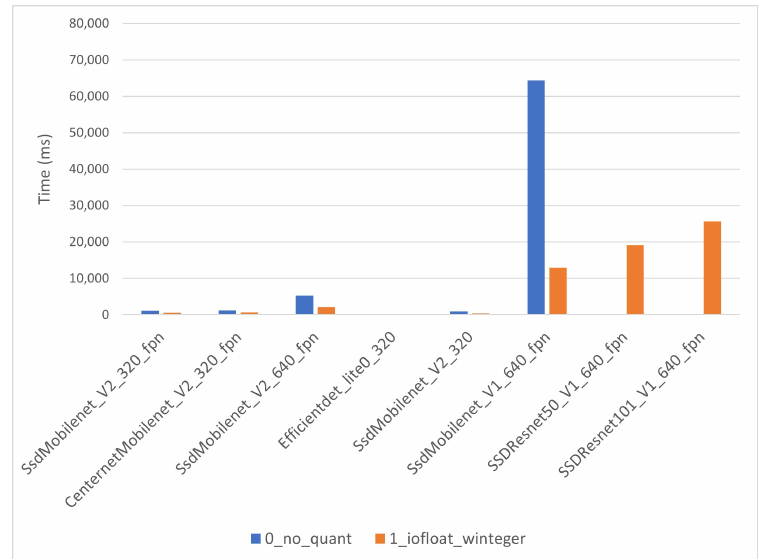
Figure 16. i-MX8M-PLUS inference time for CPU